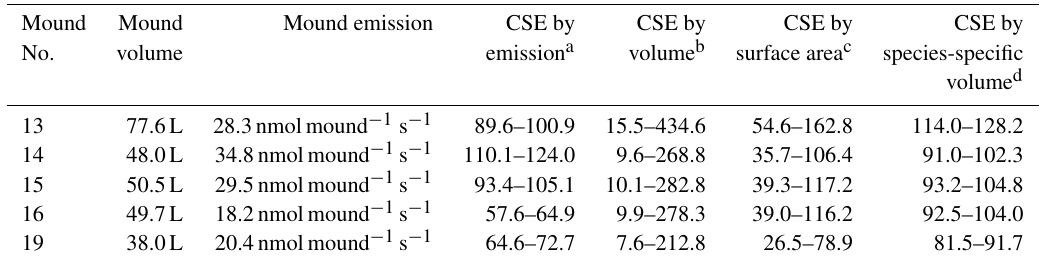
Table 3. Colony size estimates (CSEs) based on different methods; values given per thousand ( × 10 3 ). “Mound volume” is the estimated mound volume as given in Table 1 and “Mound emission” is the highest measured emission per individual mound. Mound Mound Mound emission CSE by CSE by CSE by CSE by No. emission